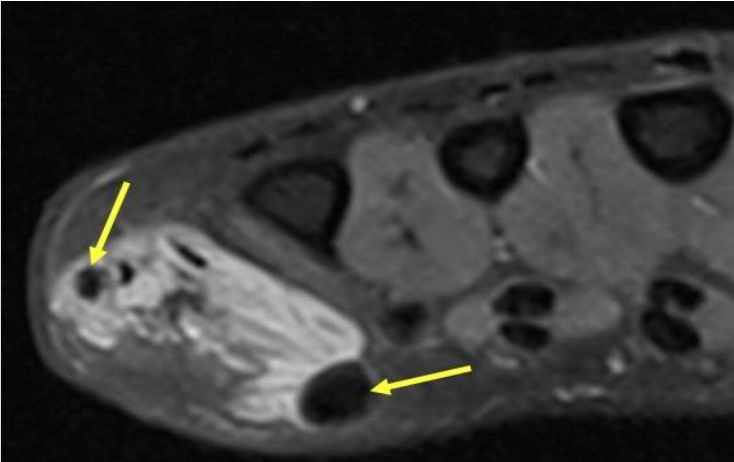
Figure 8. Venous Malformation. Axial T2 ‐ weighted axial image showing a hyperintense irregular mass on the ulnar aspect of the hand with interspersed hypointense foci (yellow arrows) consistent with phleboliths in a venous malformation. The round hypointense phleboliths are pathognomonic calcifications within thrombosed veins, and ideally would be corroborated with radiography (though unavailable in this case).